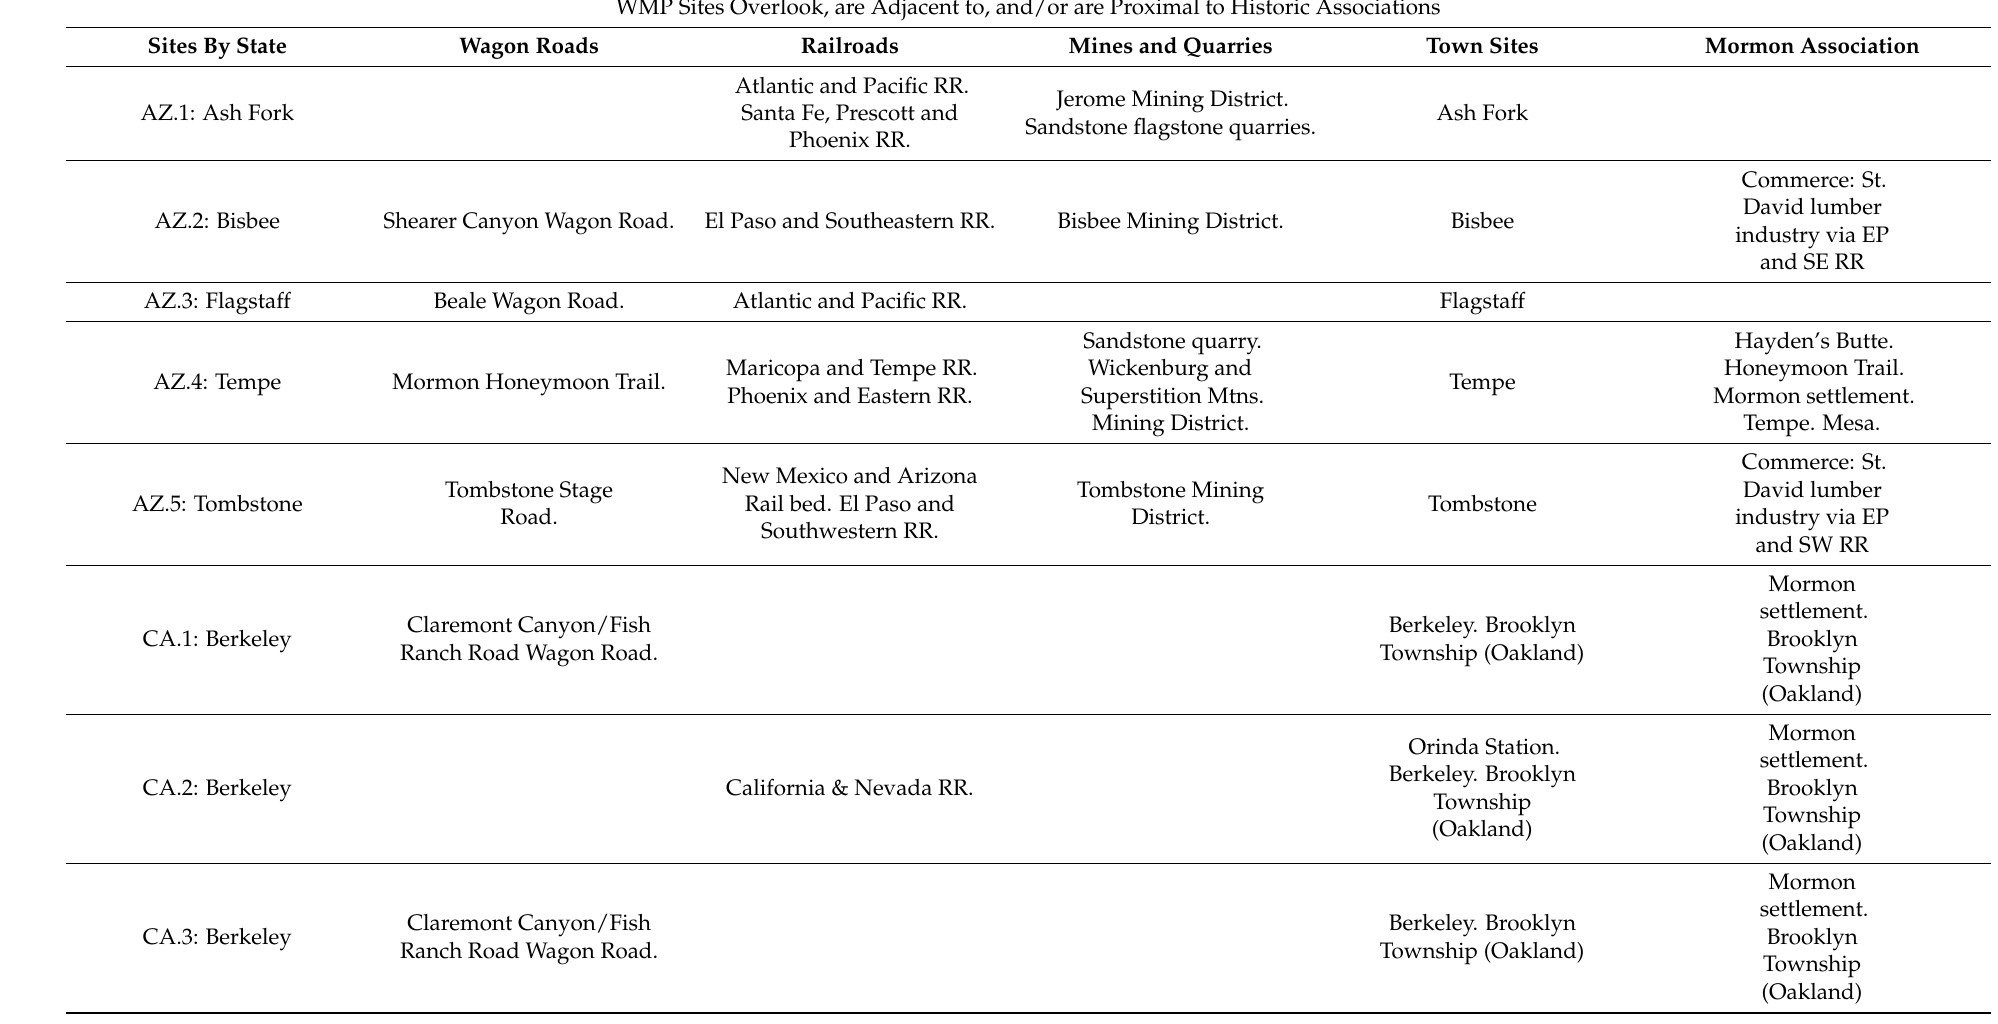
Table A2. Place specific details of WMP sites’ historic associations. WMP Sites Overlook, are Adjacent to, and/or are Proximal to Historic